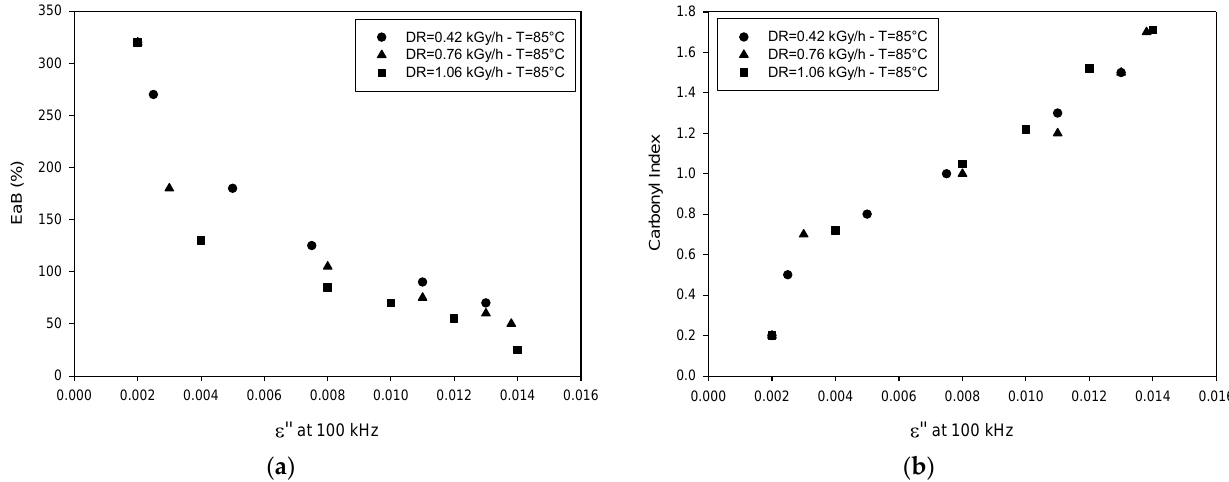
Figure 4. Cross-correlation plots: EaB vs. imaginary permittivity ( a ) and carbonyl index vs. imaginary permittivity ( b ) (after [15]).